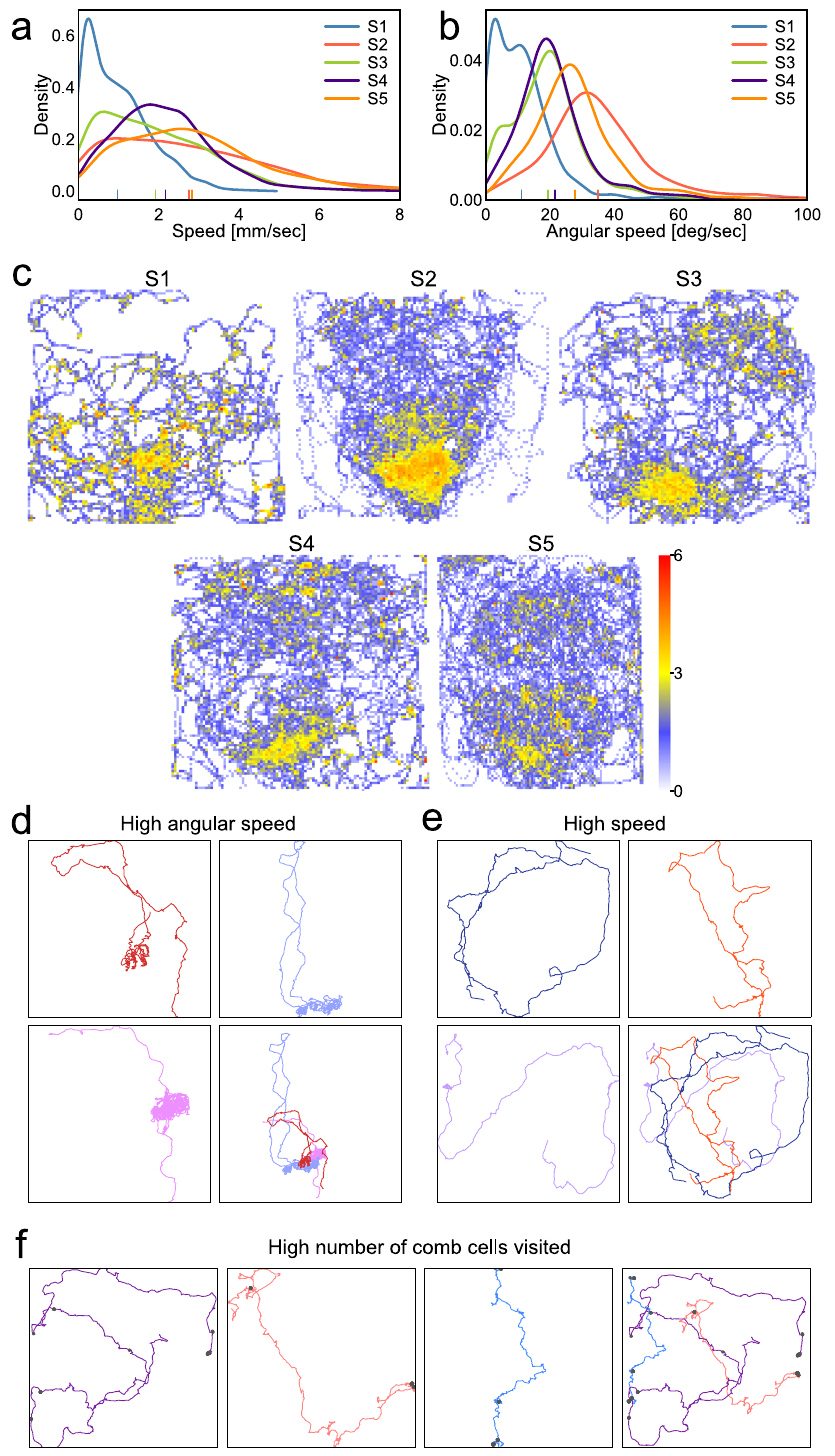
(Supplementary Fig. 17). We attribute this to the fact that data augmentation importantly increases data complexity hindering network convergence. Poorer matching accuracy on cropped images suggest that the background, including other neighboring bees, and body parts such as legs and wings play an important role in correct matching. We additionally used the collected dataset of validated trajectories to test the limits of our method to make correct matchings if the video frame rate is reduced (Supplementary Figs. 18,